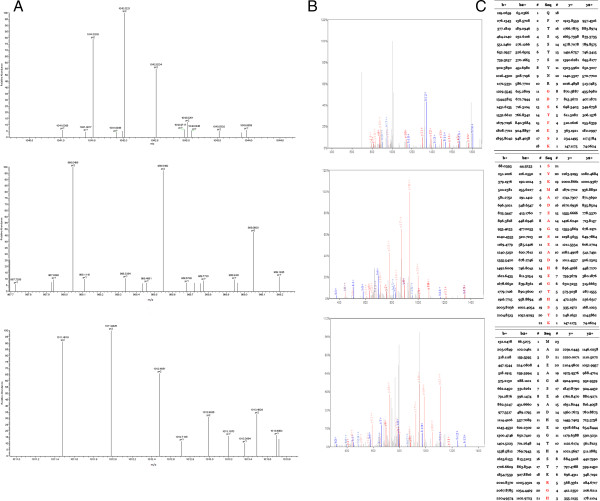
MS/MS map of peptide with MW of 4089.7 Da. (A) The enlarged picture of peptide with MW of 4089.7 Da. (B) The b and y ions spectra used to identify the peptide with MW of 4089.7 Da. (C) The sequence of the peptide with MW of 4089.7 Da.